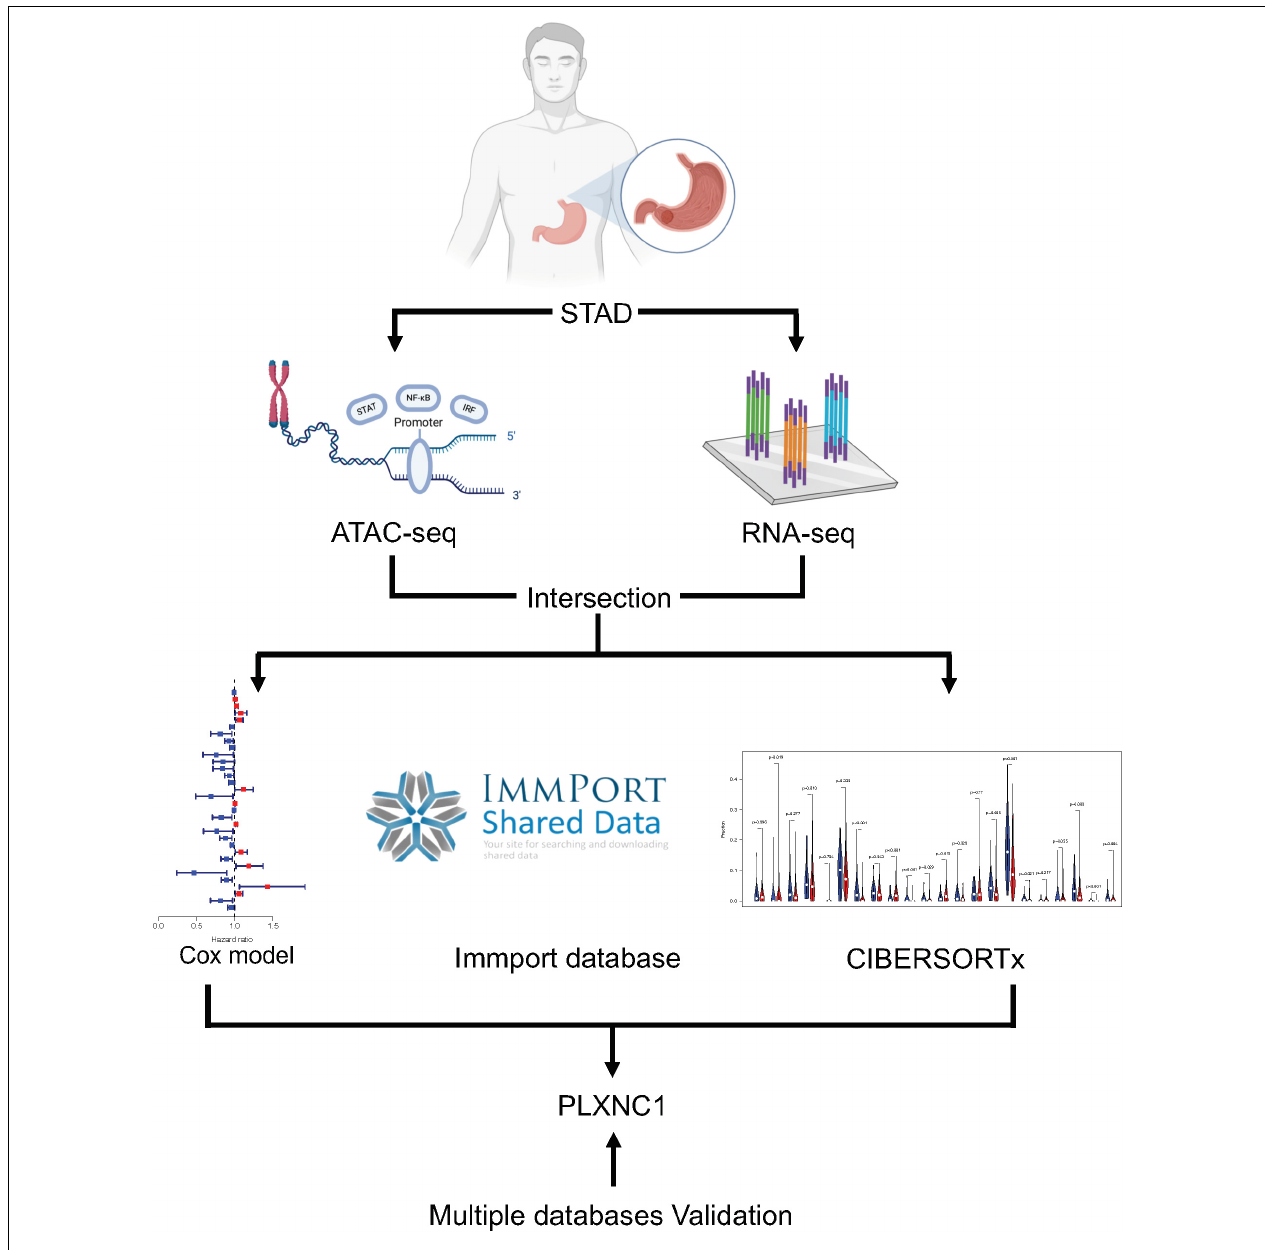
FIGURE 1 | Overview of the study